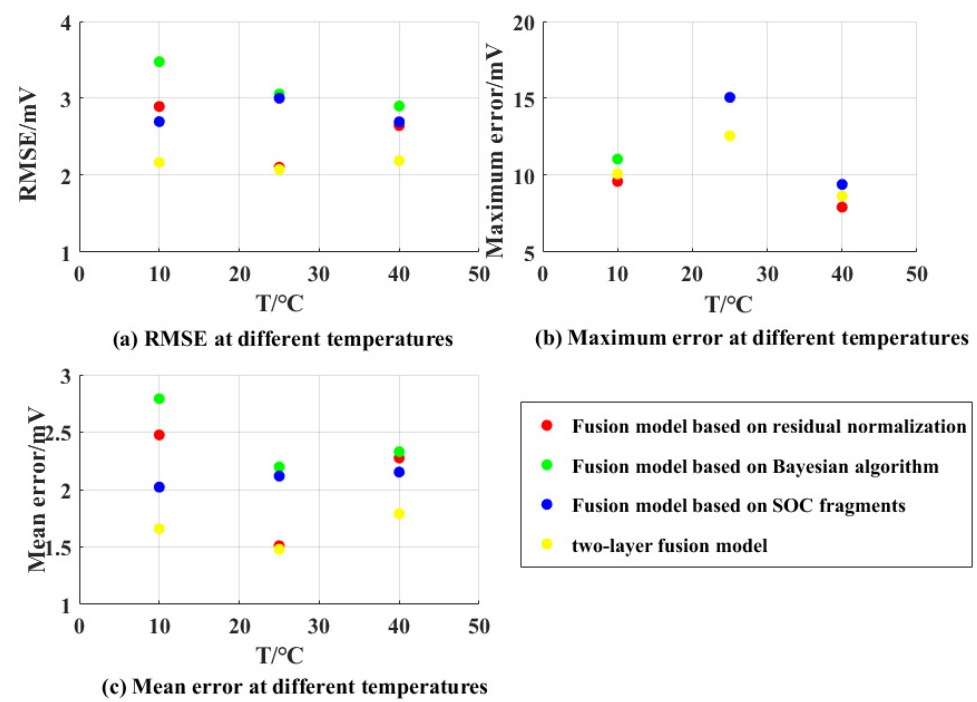
Figure 6. Comparison of the fusion model errors at different temperatures. ( a ) RMSE. ( b ) Maximum error. ( c ) Mean error.